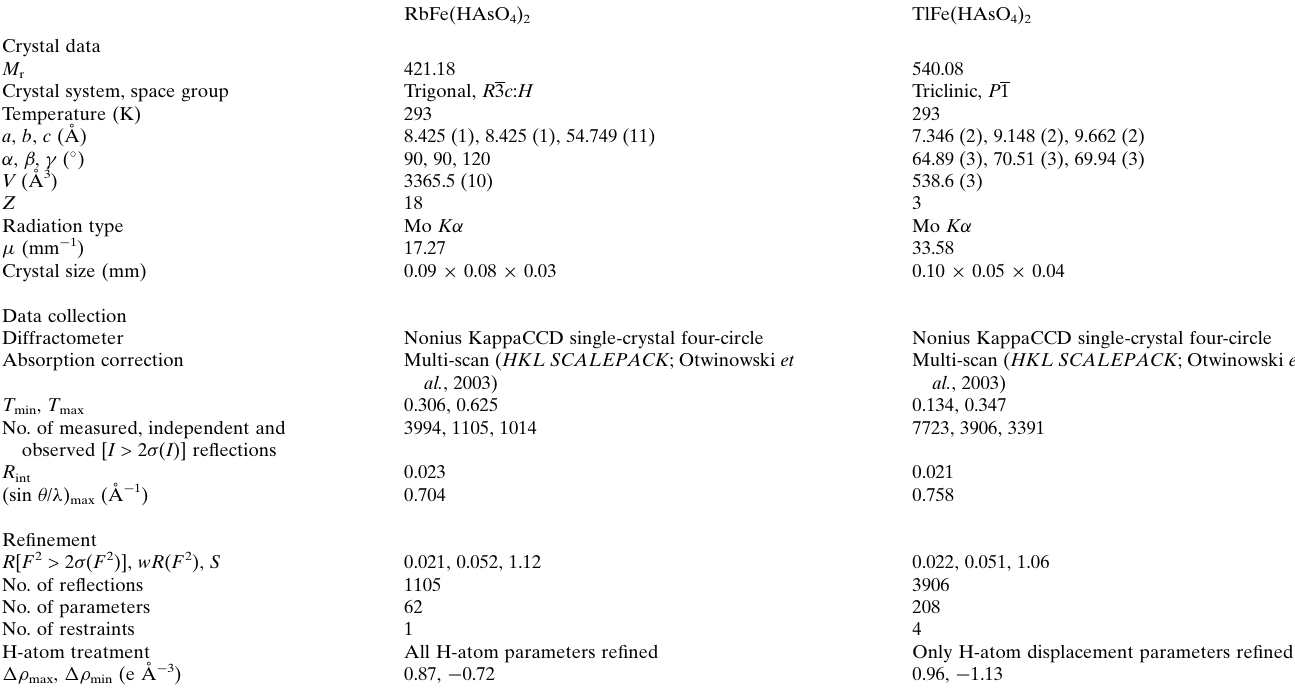
Table 6 Experimental